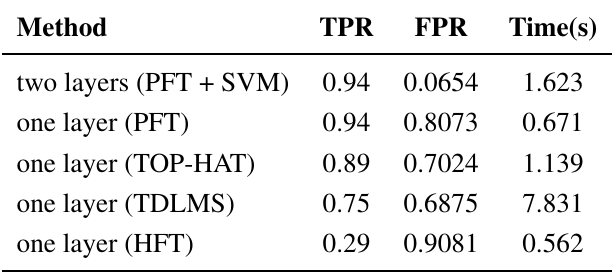
Figure 10. Time of all methods. Table 1. Compareation of TPR, FPR and time results between two layers method and one layer method ( k =